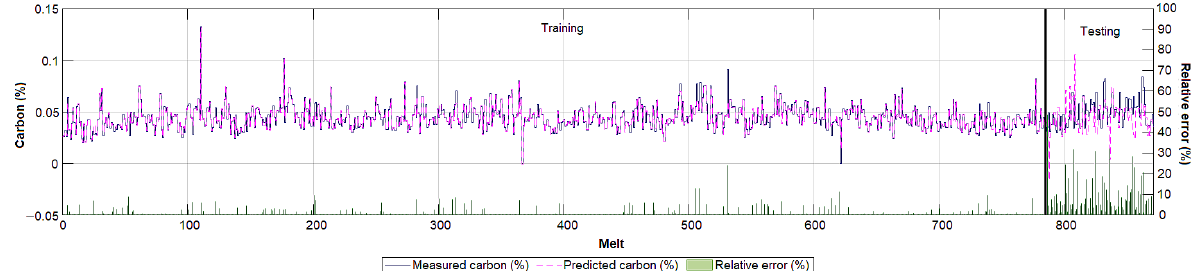
Figure 12. Prediction of endpoint carbon concentration in melt by SVR model with a polynomial